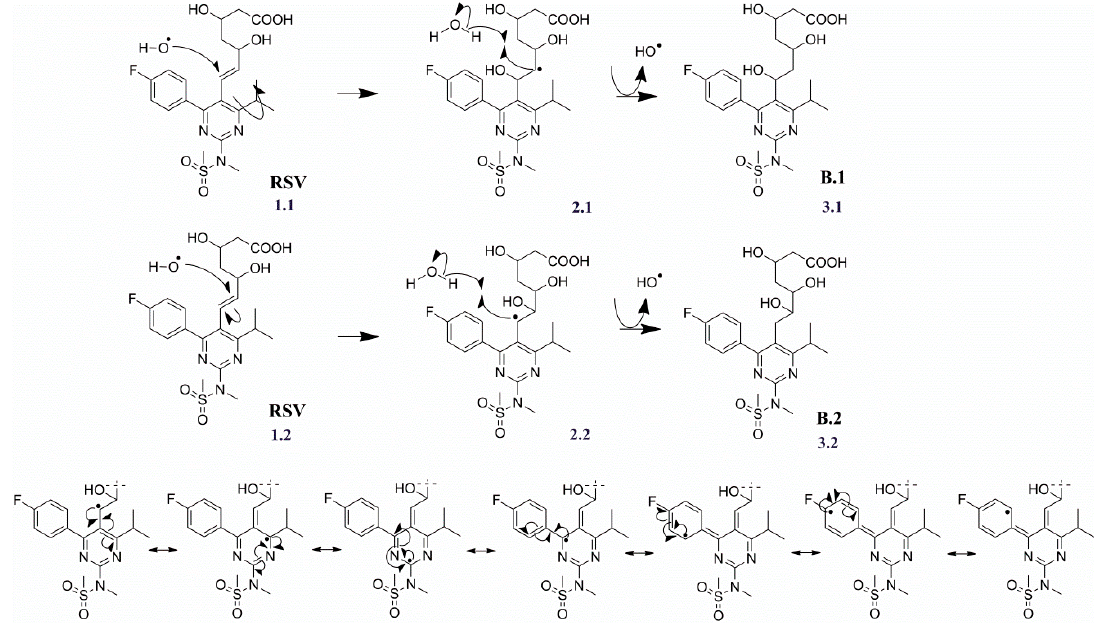
Scheme 2. Proposed mechanism of the compounds B.1 and B.2 formation by radical hydroxylation of RSV. Resonance structures showing stabilization of the intermediate product leading to the compound B.2 generation.